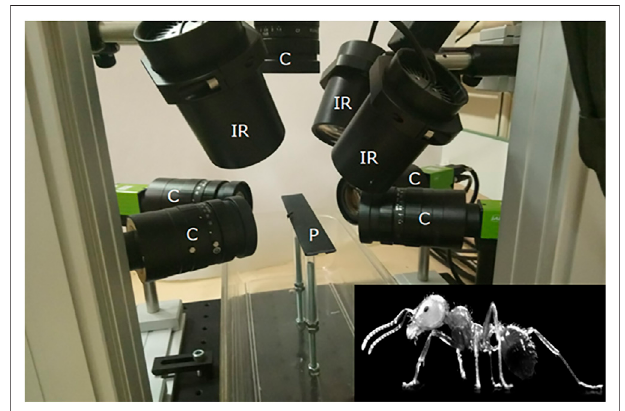
FIGURE 5 | Video acquisition system. The experimental setup was composed ofa wide walkway where the ant walked through and was